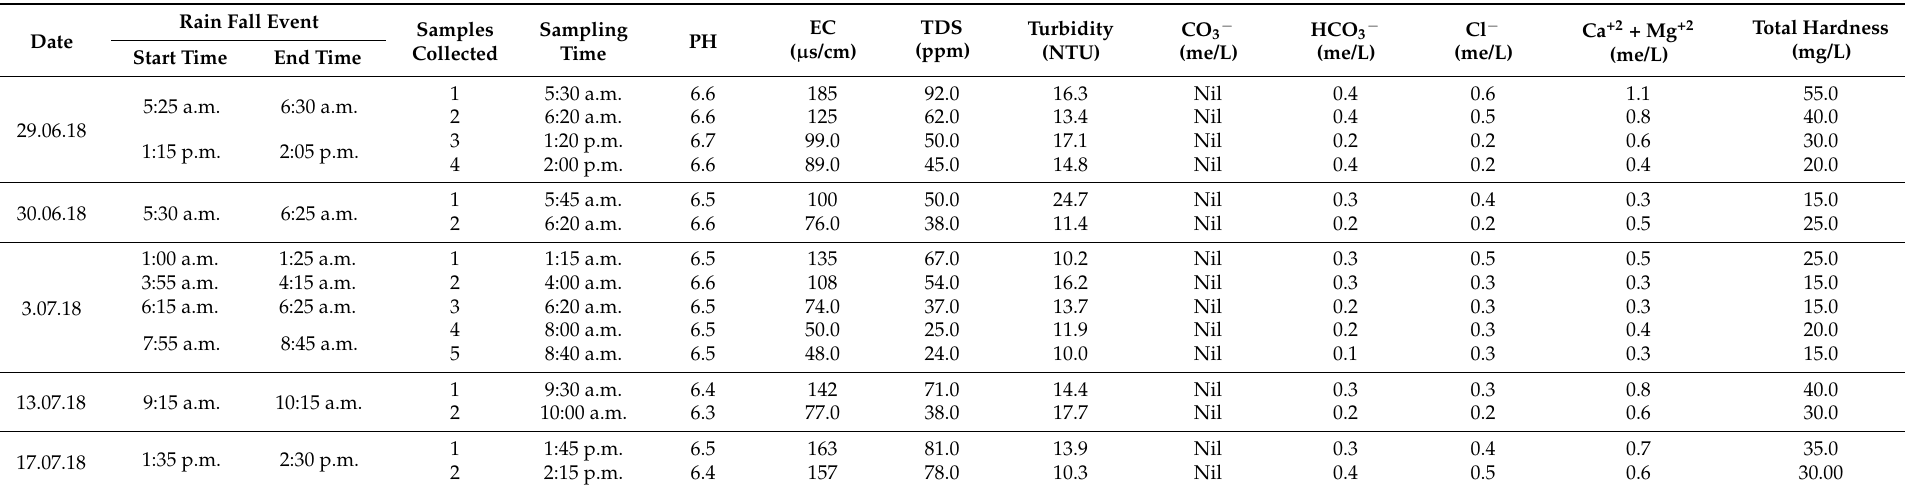
Table A10. Roof run off rain samples collected from Site 3.